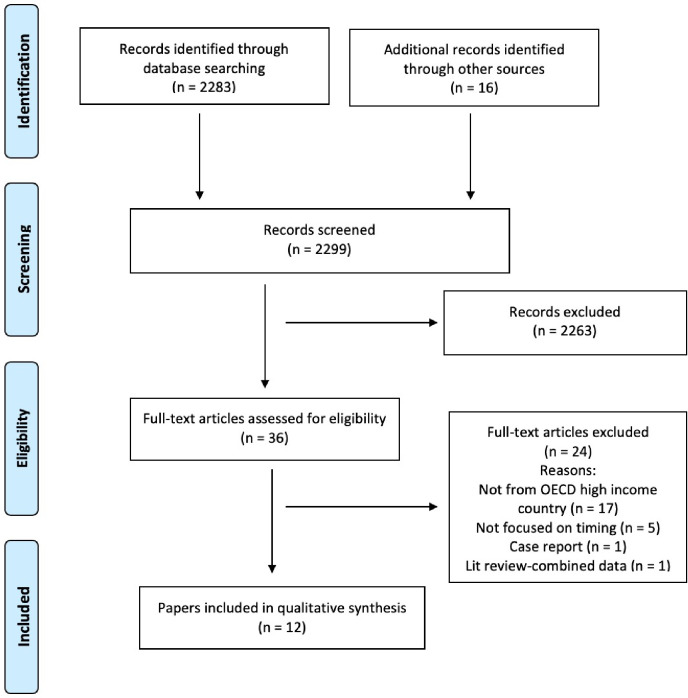
PRISMA flow diagram.